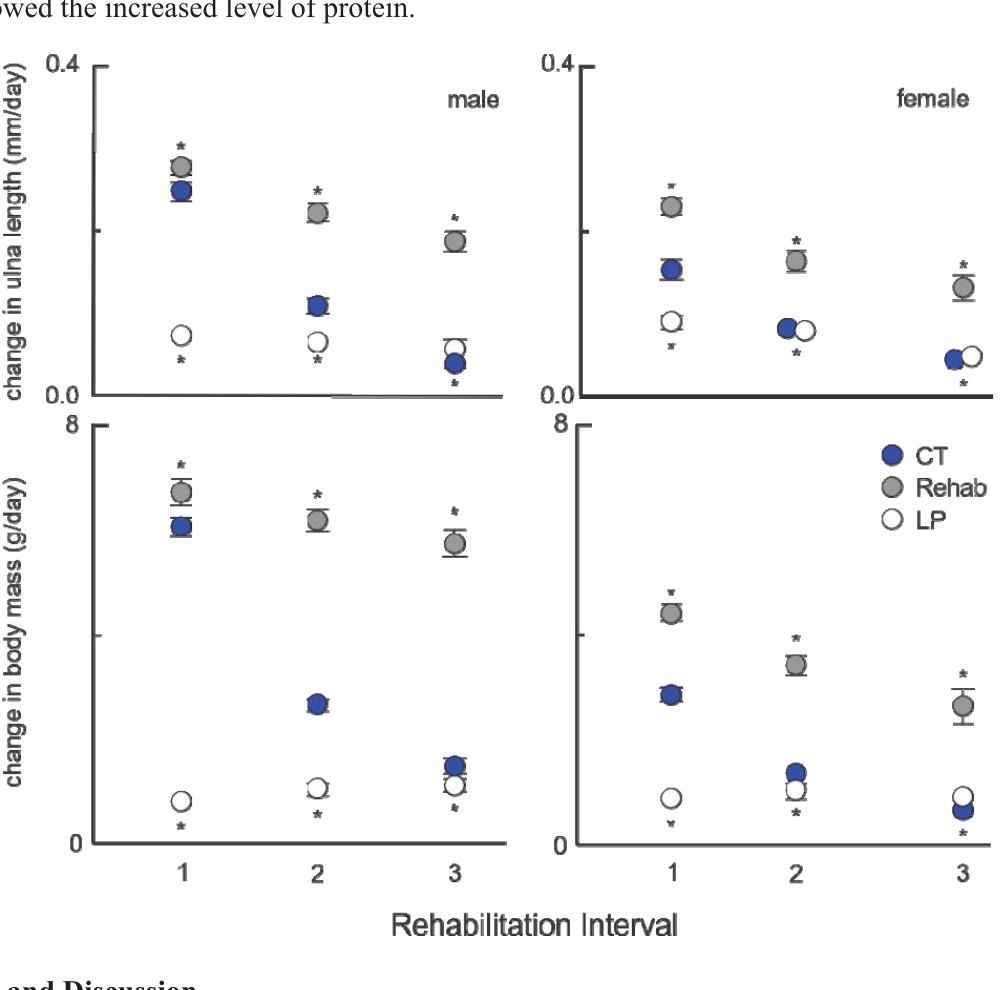
Figure 1. Post-rehabilitation growth (±standard deviation, n = 8 for each point) for males and females, modified from [1]. Individual ulna length (from radiographs, 3×/week)